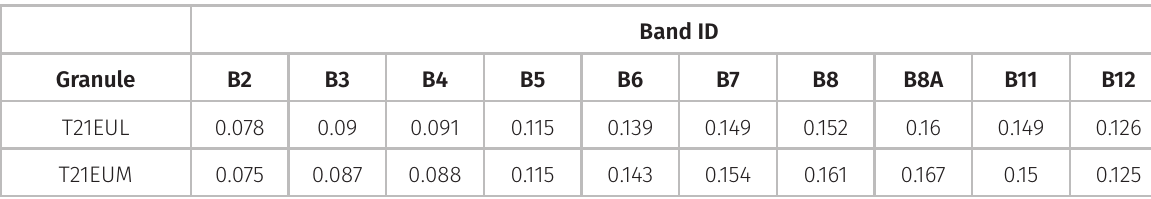
Table V. Surface reflectance values from Sentinel-2B estimated for granules T21EUL and T21EUM for the same satellite overpass over study